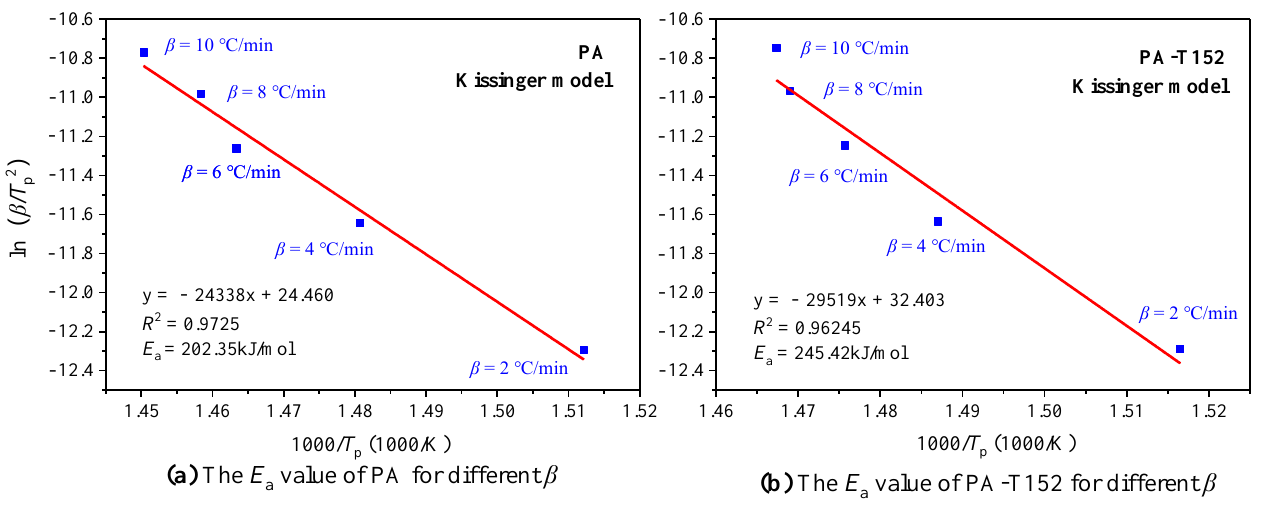
Therefore, the values of the linear fit accuracy R 2 of the two lines are 0.9725 and 0.9624, respectively, which is close to 1, indicating that both sample models have a better fit. which is close to 1, indicating that both sample models have a better fit.